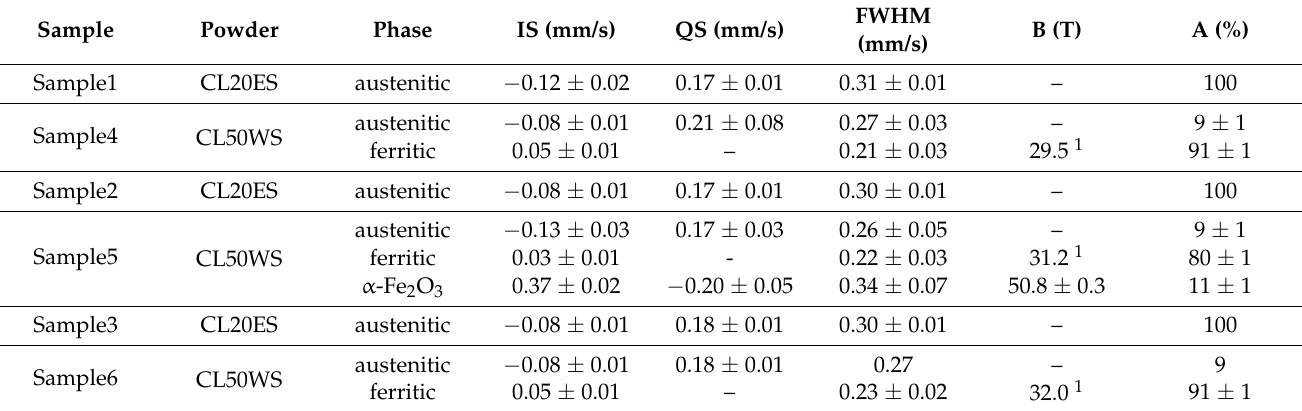
Table 4. Parameters of